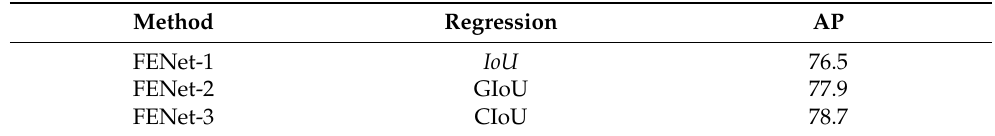
Table 3. The comparison of the detection performance among different loss functions of bounding box Table 4. Model performance of using different radii in the context-aware strategy. Radius